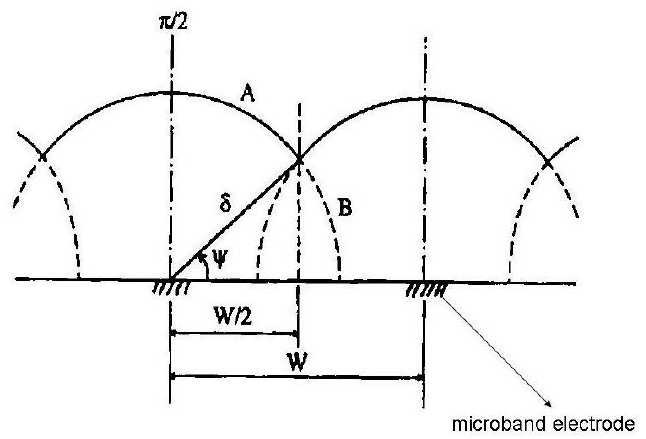
Figure 1. Cross-section model of diffusion layer overlap for a microband electrode